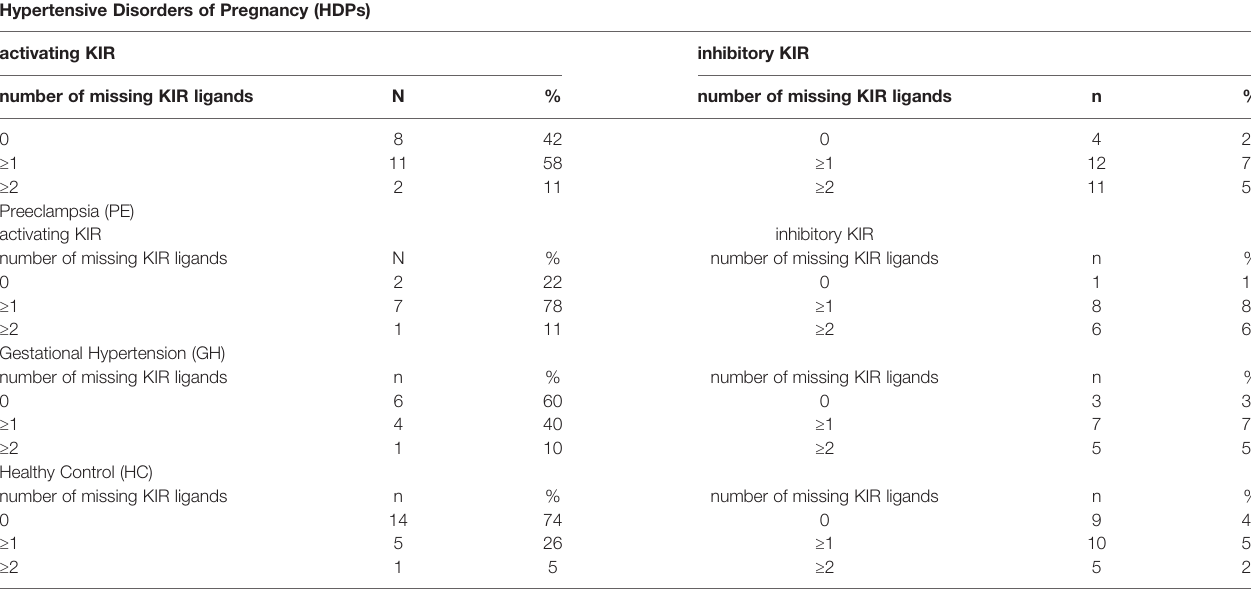
TABLE 2 | The distribution of missing KIR ligands that occurred in the HDP (PE and GH) and in the healthy control group.